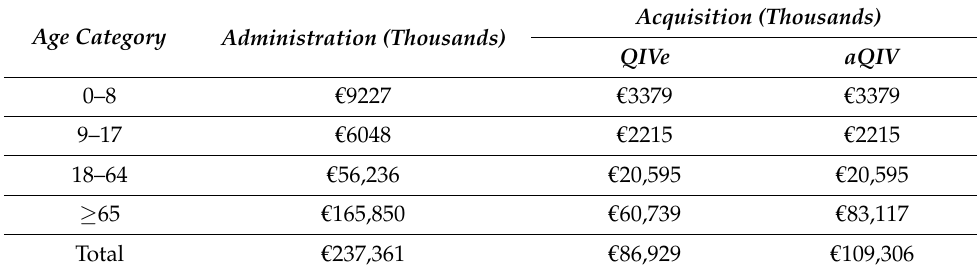
Table 13. Vaccine acquisition and administration